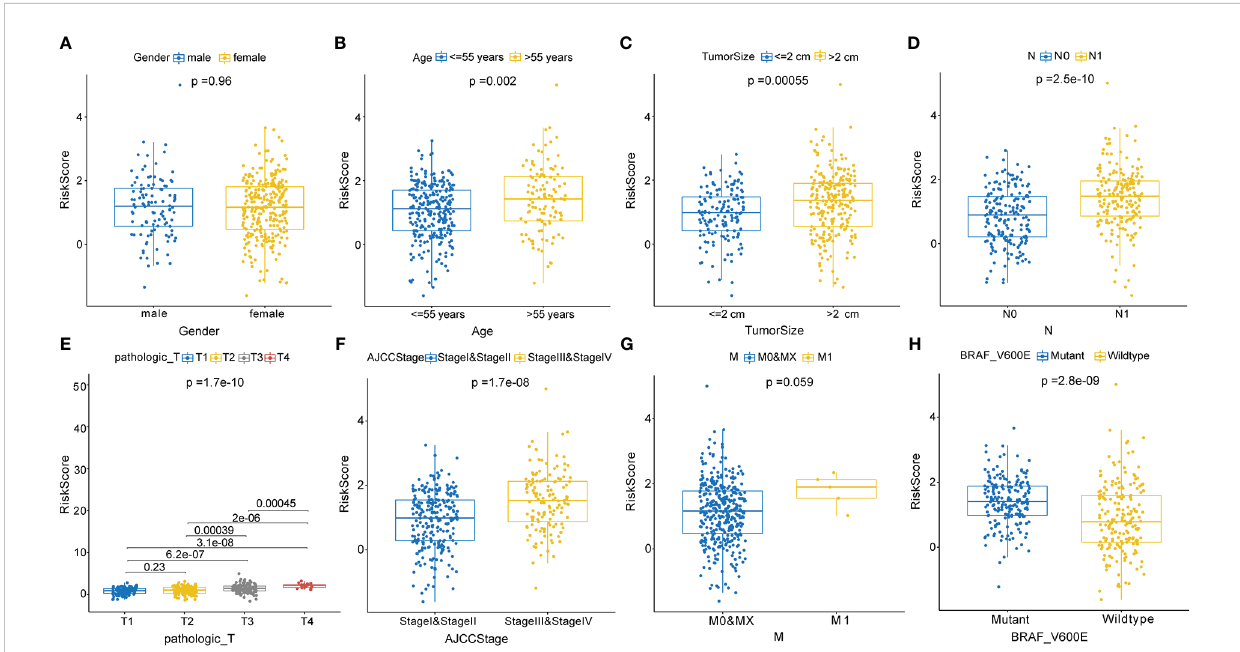
FIGURE 4 Correlations between the risk score based on the signature and clinical characteristics. (A) Male and female. (B) Age ≤ 55 years and > 55 years. (C) Tumor size ≤ 2 cm and > 2 cm. (D) N0 and N1 stage. (E) T1, T2, T3, and T4 stage. (F) AJCC stages I and II and stages III and V. (G) M0, MX, and M1stage. (H) Mutant and wild-type BRAFV600E.